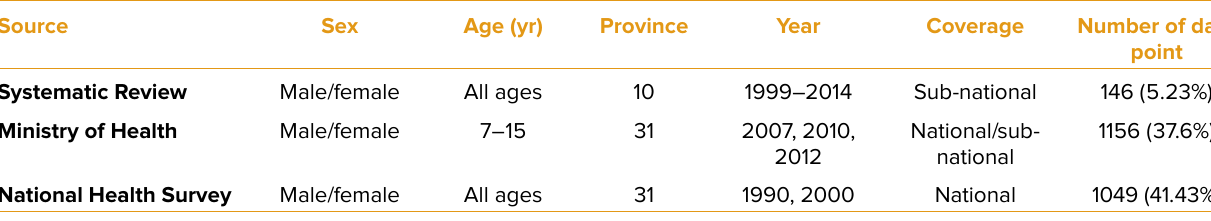
Table 1. Data source specifications.